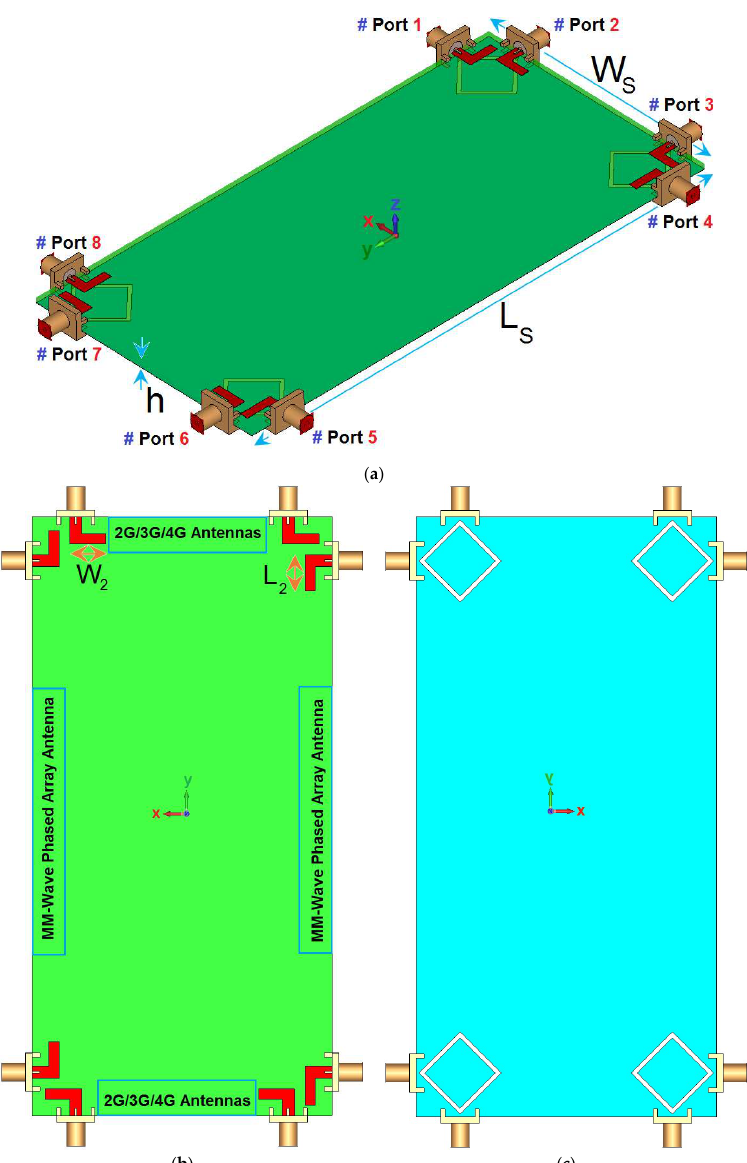
Figure 9. Designed mobile-phone antenna ( a ) transparent view, ( b ) top-layer and ( c ) bottom layer.